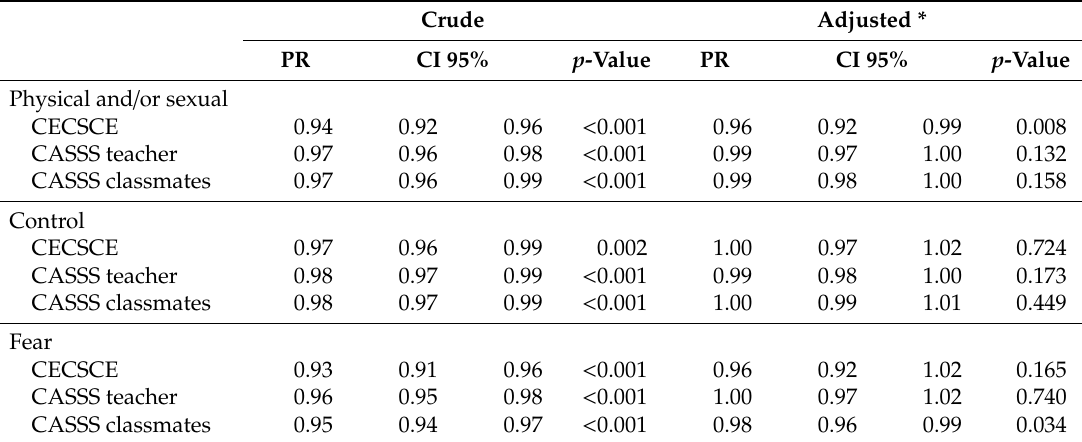
Table 4. Poisson regression with robust variance. Association between school social support and the di ff erent types of dating violence /